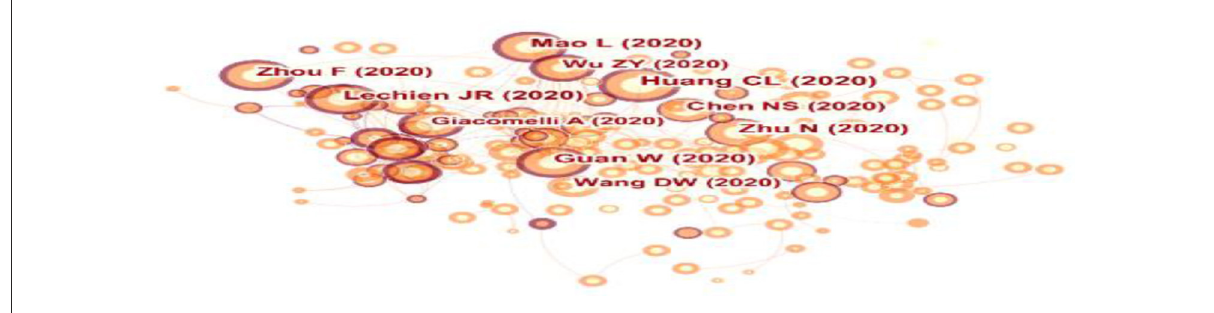
FIGURE5 An interconnected web of citations.